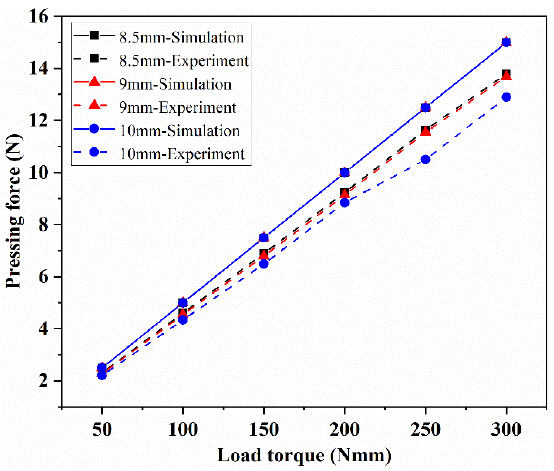
Figure 25. The influence of steel ball diameter on the pressing force.